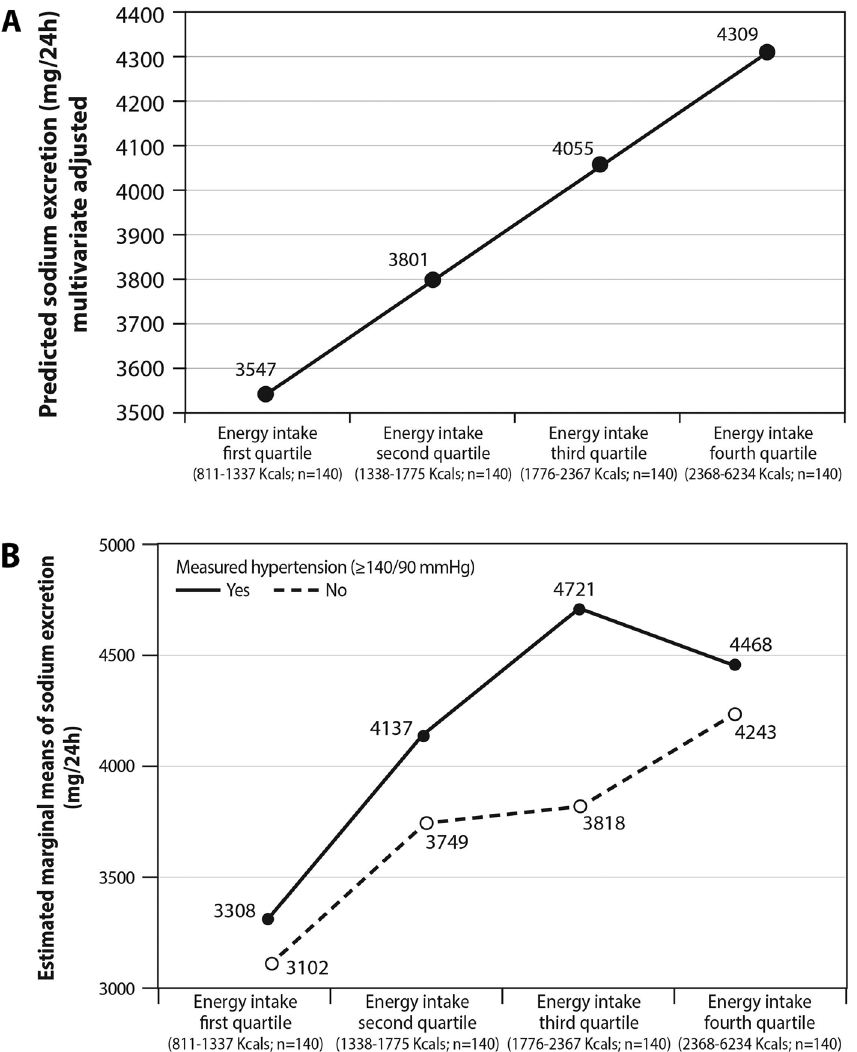
Figure 1. Sodium excretion as a function of energy intake, adjusted for other explanatory variables ( A ); The interaction between energy intake and the presence of hypertension in relation to sodium excretion—a two-way ANOVA analysis ( B ). ( A ) The line shows the predicted values of sodium excretion in the different energy intake quartiles, adjusted to other explanatory/confounding variables which can be seen in the formula below. Values represent the scenario where each coefficient of the explanatory variables is multiplied either by "1" or "0". Variables with coefficients multiplied by "1" were energy quartile and BMI. The rest were multiplied by "0". Multivariate linear regression formula: Y = 2698 + 254 ∗ (cid:31) energy quartile (cid:30) + 145 ∗ (cid:31) Measured hypertension ≥ 140 / 90 = 1 vs . other = 0 (cid:30) + 595 ∗ ( BMI ≥ 30 = 1 vs . < 30 = 0 ) + 665 ∗ (cid:31) sex , male = 1 ; female = 0 (cid:30) − 410 ∗ (cid:31) CHDdiagnosis ., yes = 1 ; no = 0 (cid:30) + 256 ∗ (cid:31) Diabetesdiagnosis , yes = 1 ; no = 0 (cid:30) − 0.318 ∗ (cid:31) age , ≥ 45 = 1 ; else = 0 (cid:30) + 95 ∗ ( ideal physical activity by ASCM recommendations , yes = 1 ; no = 0 ) . Energy intake was positively linked to increase in sodium excretion (p < 0.001, R 2 = 13.1%). ( B ) Energy intake was positively associated with an increase in sodium excretion regardless of hypertension status (P < 0.001 across quartiles). Hypertension (≥ 140/90 mmHg) was also positively linked to sodium excretion (p = 0.006 between hypertensive compared to normotensive subjects). Indicated by the relatively parallel lines, as well as by Between-Subjects Effects Test, there was no overall interaction between caloric intake and hypertension in relation to sodium excretion (p = 0.361) suggesting that the joint effect of hypertension and caloric intake the combined is less than the sum of their individual effects (no synergistic effect on sodium excretion). Error variance of the sodium excretion is equal across groups using the Levene’s Test for homogeneity (p =